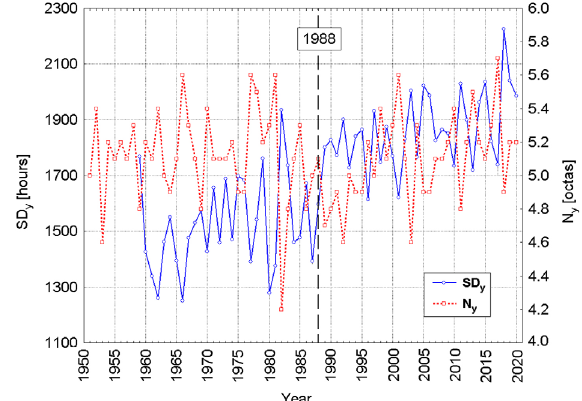
Fig. 5. The annual SD and annual total cloud cover y (N ) in Poznań in 1951–2020. The year of temperature y and SD discontinuity is marked with vertical dashed y line. SD, sunshine